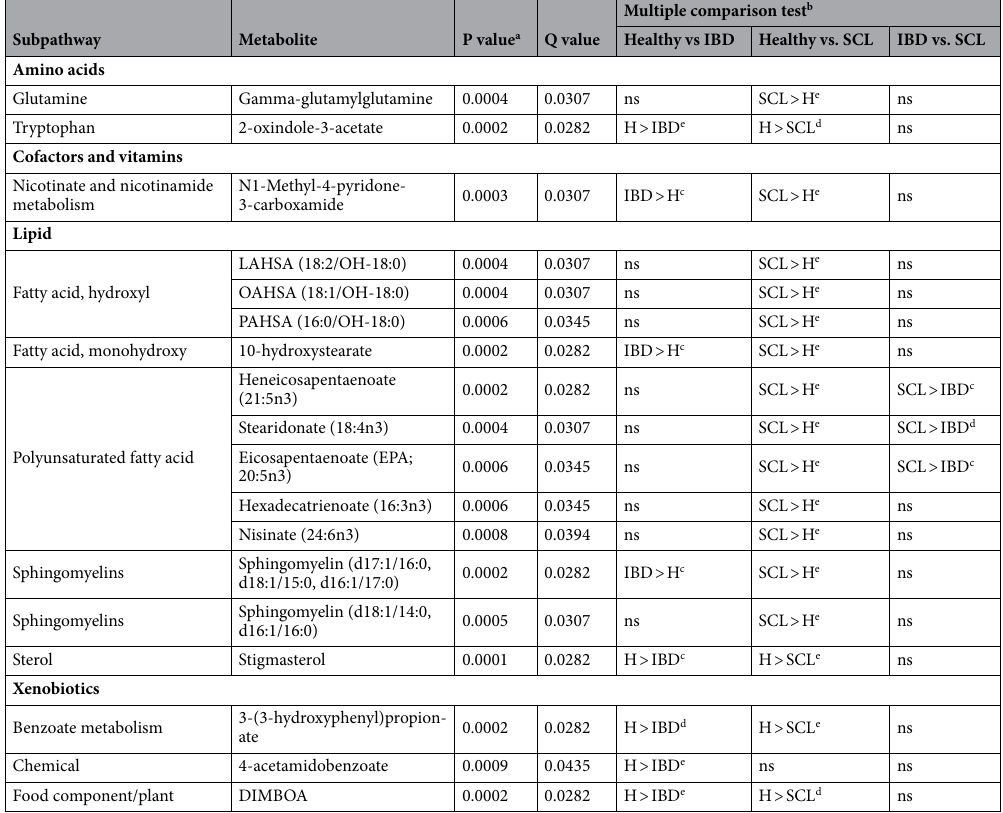
Table 4. Significance of metabolites for the discrimination between the three groups, healthy controls, cats with inflammatory bowel disease (IBD), and cats with alimentary small cell lymphoma (SCL). n s not significant. a Kruskal-Wallis test, three groups. b Dunn’s post hoc. c 0.01 < P < 0.05. d 0.001 < P < 0.01. e P < 0.001.